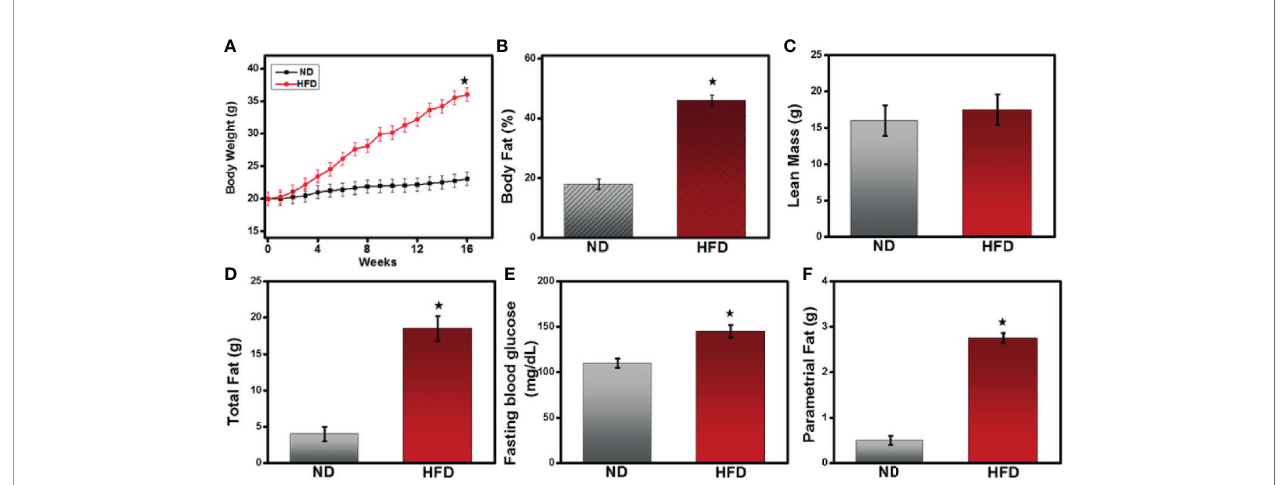
FIGURE 1 | High-fat diet induces metabolic parameters and body weight. 8-week-old male C57BL6 mice were fed a normal diet (ND, □ ) or a high-fat diet (HFD, ■ ) for 16 weeks, and their body weight was recorded twice a week. (A) Changes in body weight are expressed as a gram of measured ± mean body weight weekly. (B) Body fat, (C) lean body mass; (D) total fat; (E) fasting blood glucose; and (F) parametrial fat were measured at the experimental endpoint at the 16 th week before euthanization of mice. The statistical signi fi cance between values of each group was assessed by an unpaired Student ’ s t-test. *p < 0.05 indicate statistically signi fi cant differences in body weight, body fat, total fat, fasting blood glucose, and parametrial fat between ND-fed mice and those fed HFD. Values are mean ± SEM; total n = 18 (six mice per group). Data represent the mean of three experiments involving six mice per group with three repeats.